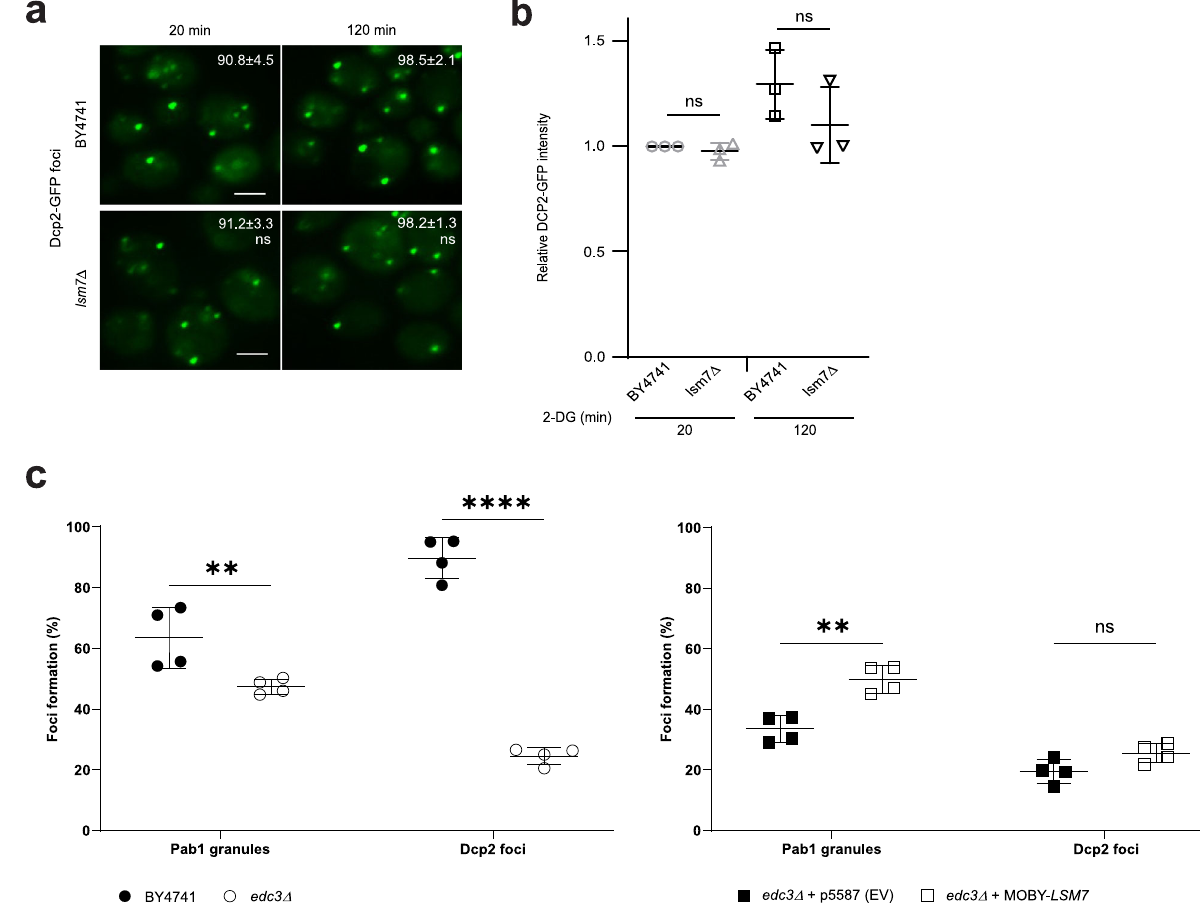
Fig. 3 Lsm7 impacts SG formation without affecting PB formation. a PB formation is not signi fi cantly changed in the lsm7 Δ mutant. WT (BY4741) and lsm7 Δ mutant strains were treated with 2-DG for 20 min and 120 min, followed by sample collection and imaging. Values represent percentage of cells with Dcp2-GFP foci and are shown as mean ± S.D. Scale bar indicates 2 µ m. Six biologically independent experiments were examined and >300 cells were analyzed for each (unpaired two-tailed t test). Left to right: ns = 0.8732, ns = 0.7548. b There is no statistically signi fi cant difference in the relative Dcp2- GFP signal intensity for the WT (BY4741) and the lsm7 Δ mutant. Individual value points are shown with mean ± S.D. Three biologically independent experiments were examined for each strain and one representative image for each was analyzed for GFP signal (unpaired two-tailed t test). Left to right: ns = 0.1189, ns = 0.6956. c Overexpression of LSM7 can increase the 2-DG-induced SG formation in the SG- and PB-de fi cient edc3 Δ mutant. Deletion of EDC3 results in a decrease in SGs (Pab1-RFP) and PBs (Dcp2-GFP), as compared to the WT (BY4741) (left). The SG phenotype can be partially rescued by overexpression of LSM7 , without affecting the number of PBs, as compared to the empty vector control (right). Individual value points are shown with mean ± S.D of percentage of cells with Pab1-RFP granules and Dcp2-GFP foci. Four biologically independent experiments were examined and >200 cells were analyzed for each (two-way ANOVA followed by Tukey ’ s test). Left to right: ** p = 0.0014, **** p < 0.0001, ** p = 0.0011, ns = 0.4091. Source data are provided as a Source Data fi